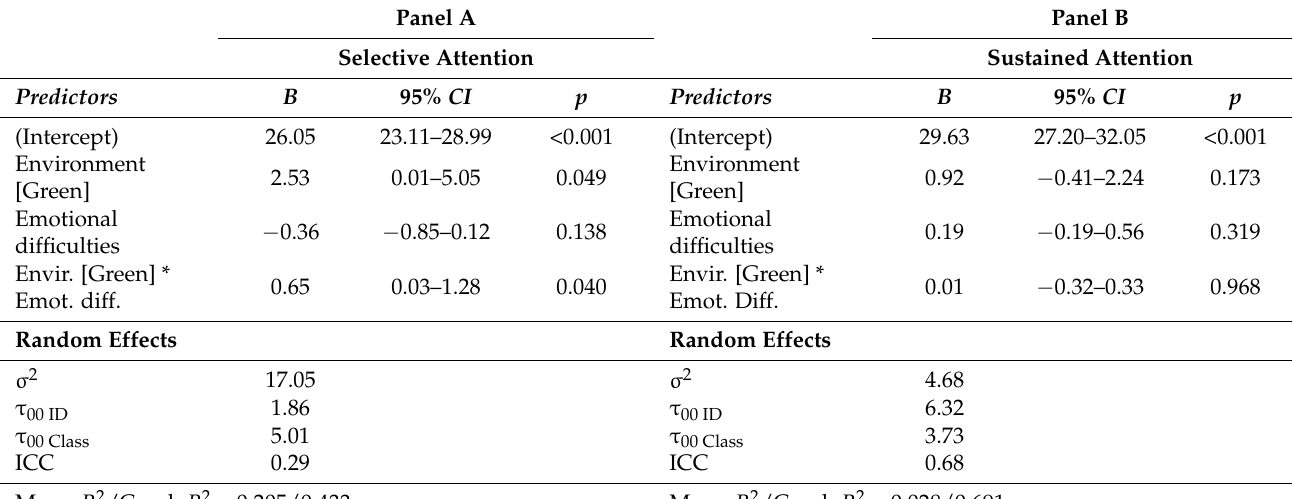
Table 2. Linear mixed models for selective and sustained